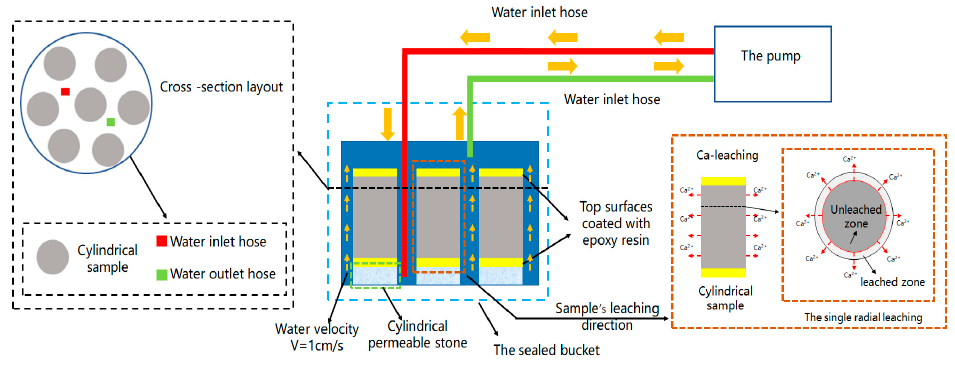
Figure 3. Schematic of the RNW